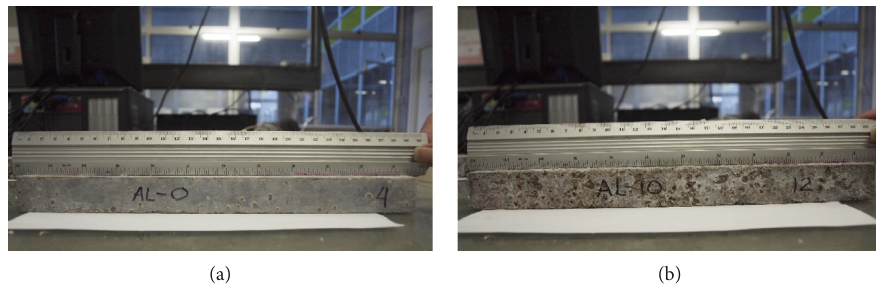
Figure 7: Concrete exposed to MgSO